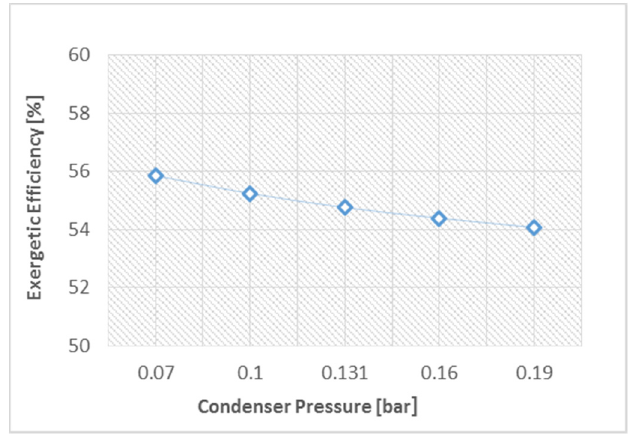
Figure 5. Exergetic efficiency versus condenser pressure at ISO condition.